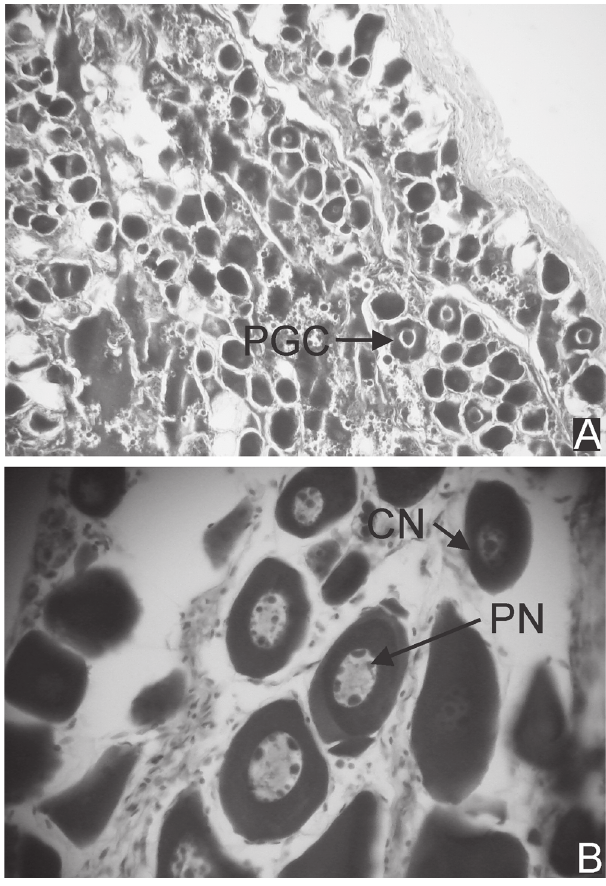
Fig. 5. Ovary sections of the dusky grouper ( Mycteroperca marginata ) collected in the study area. A ) Immature gonad showing several primary germ cells (PGC) and oogonia. B ) Resting gonad with small previtellogenic oocytes in chromatin nucleolus stage (CN) and in perinucleolar stage (PN).